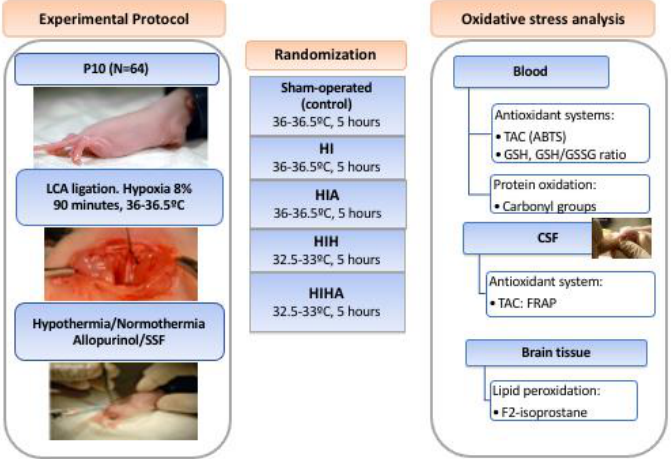
Figure 1. Study Diagram: Experimental Protocol, Randomization, and Oxidative stress